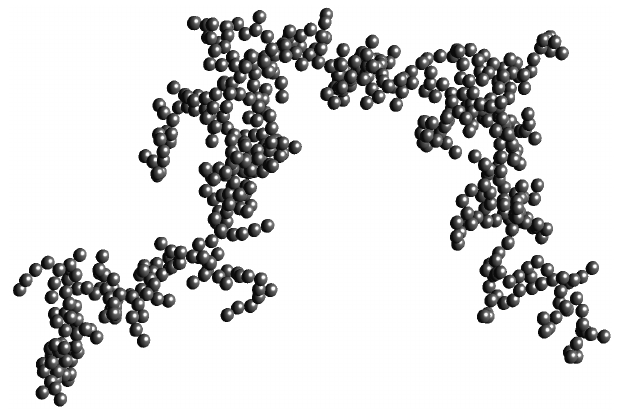
Fig. 1. Light absorbing carbon aggregate with N s = 600 pri- mary monomers, fractal dimension D f = 1 . 82, and structure factor k 0 = 1 .